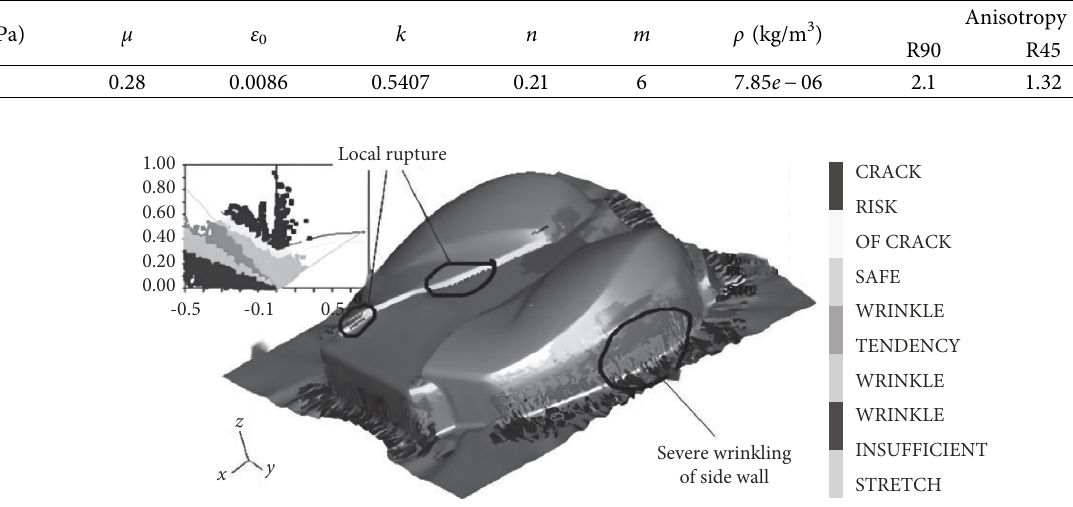
Figure 4: Stamping forming limit diagram.